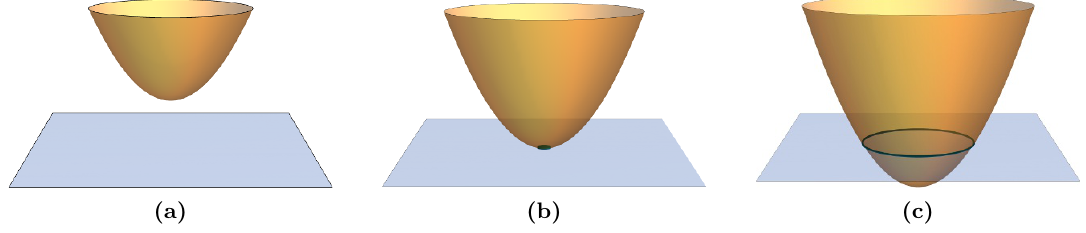
Figure 1. The energy dispersion for (a) insulator, (b) critical point and (c) metal plotted in the two-dimensional momentum space. The dot in (b) represents the bottom of the band which touches the chemical potential at the critical point, and the circle in (c) represents the Fermi